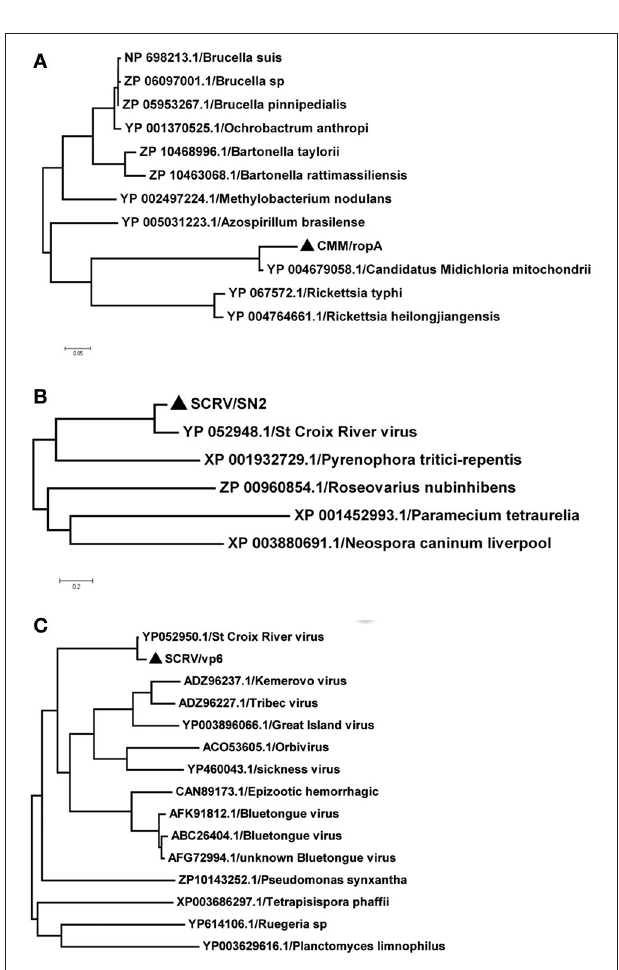
FIGURE 4 | Phylogenetic analysis of the isolated bacteria/viruses. The phylogenetic tree was generated using MEGA 5.0 with maximum parsimony and 500 bootstrap replicates. Reference amino acid sequences were selected by BLAST searches of the NCBI nt database. (A) Subtrees of the experimental sequences from the CMM rpoA gene. (B) Subtrees of the experimental sequences from the SCRV SN2 gene. (C) Subtrees of the experimental sequences from the SCRV Vp6